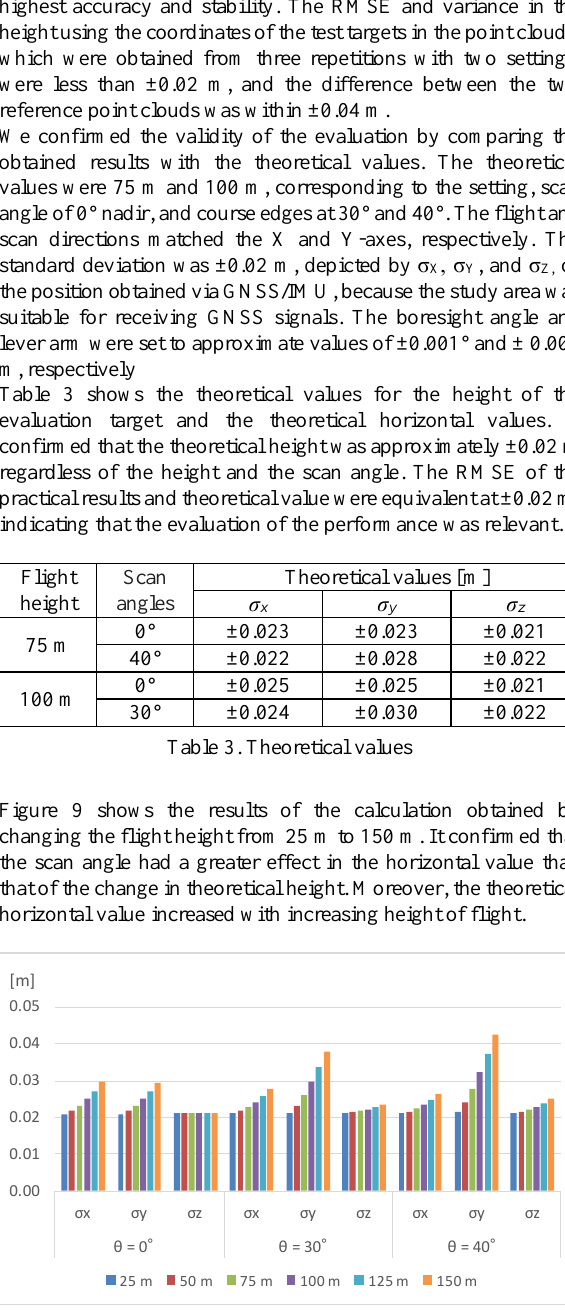
Figure 9. Theoretical